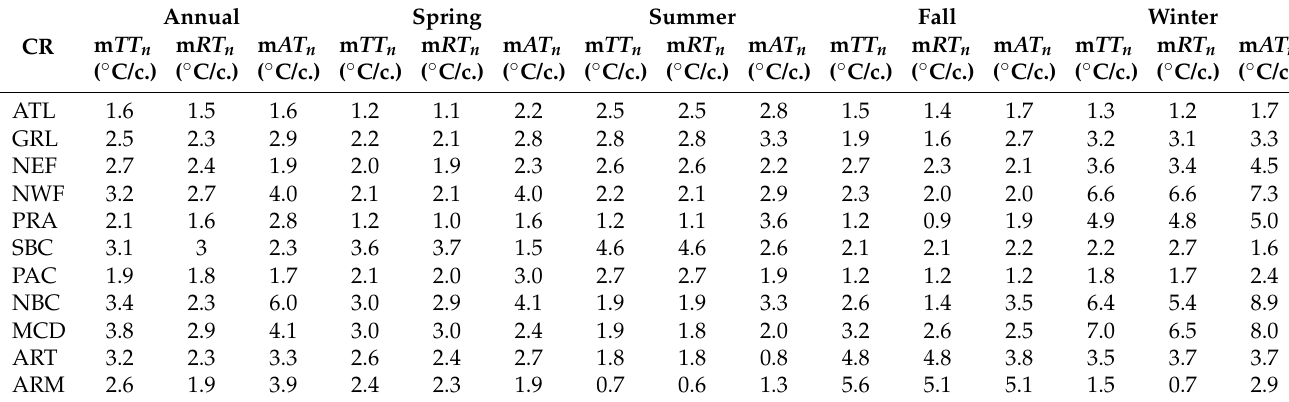
Table 8. Regional temperature minima slopes reported in degrees Celsius per century ( ◦ C/c.) “m” represents “slope”. m TT n —Slope of Total Temperature Maximum, m RT n —Slope of Ra- diative Temperature Maximum, and m AT n —Slope of Advective Temperature Maximum. “CR” represents “climate region”. ATL—Atlantic Canada, GRL—Great Lakes/St. Lawrence Low-